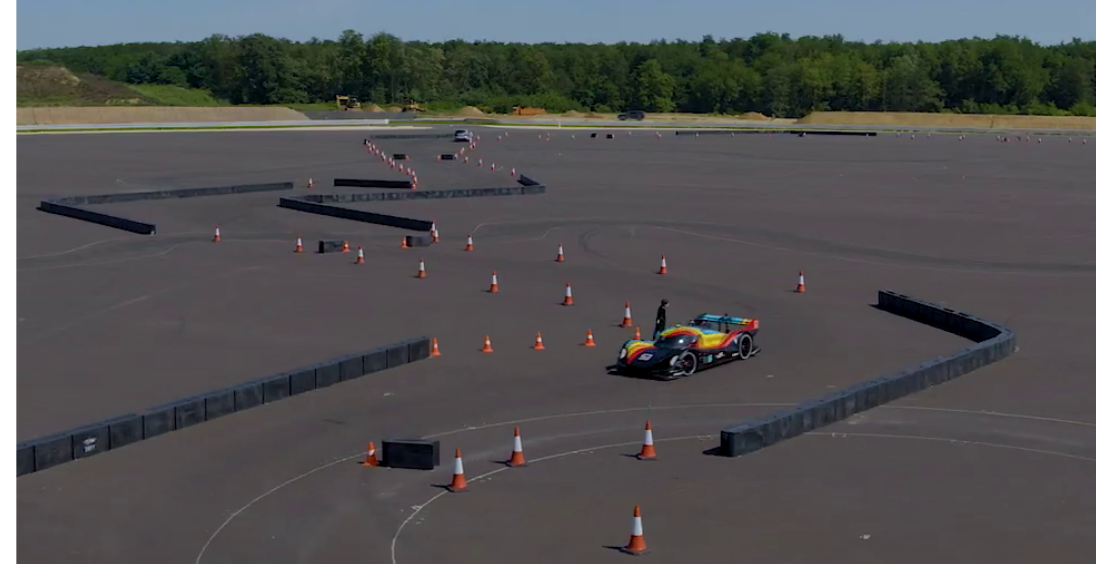
Figure 1. Roborace DevBot 2.0 in the Zala Zone Circuit. Localization challenges were performed in this circuit, and the presented localization framework was